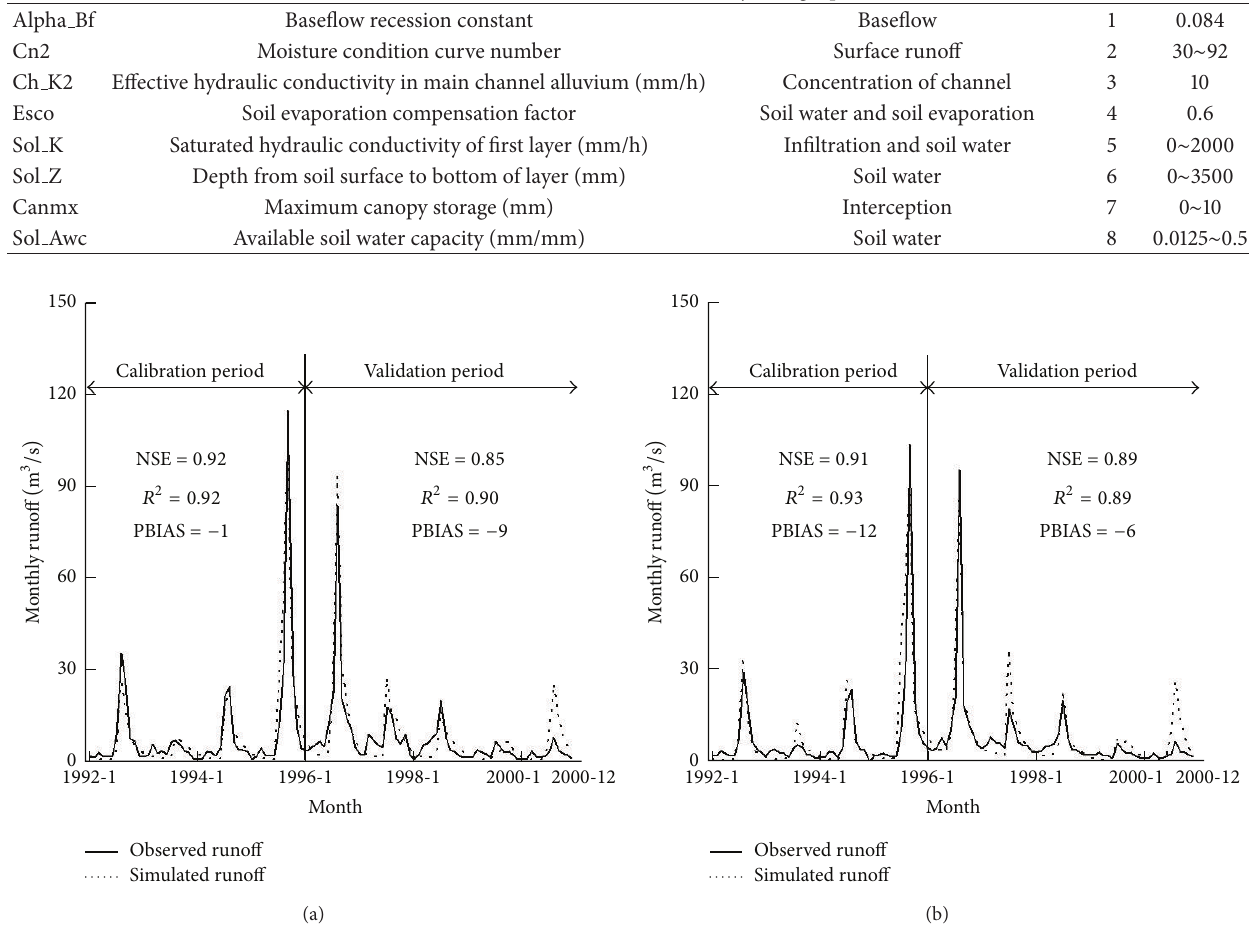
Figure 4: Monthly simulated and observed runoff in the Upper Fenhe River watershed. ((a) Hecha station; (b) Jingle station.)